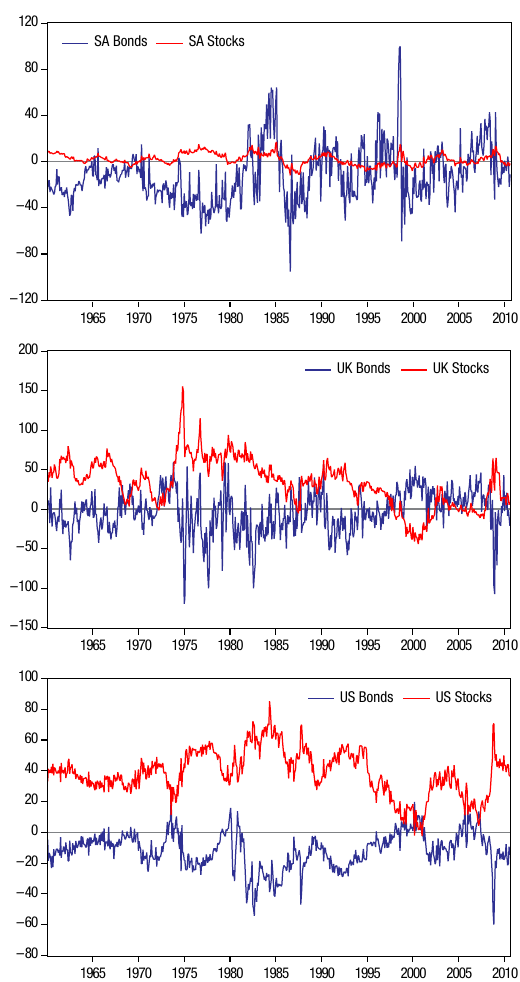
Fig. 1. Historical intertemporal hedging demands for domestic stocks and bonds in SA, the UK and the US when g = 7 and y =